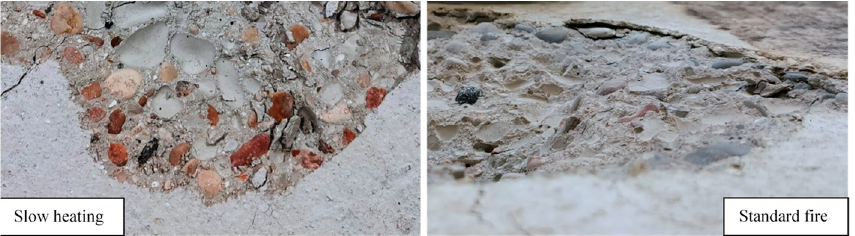
Figure 11. Discoloration of the aggregate particles near the exposed surface.